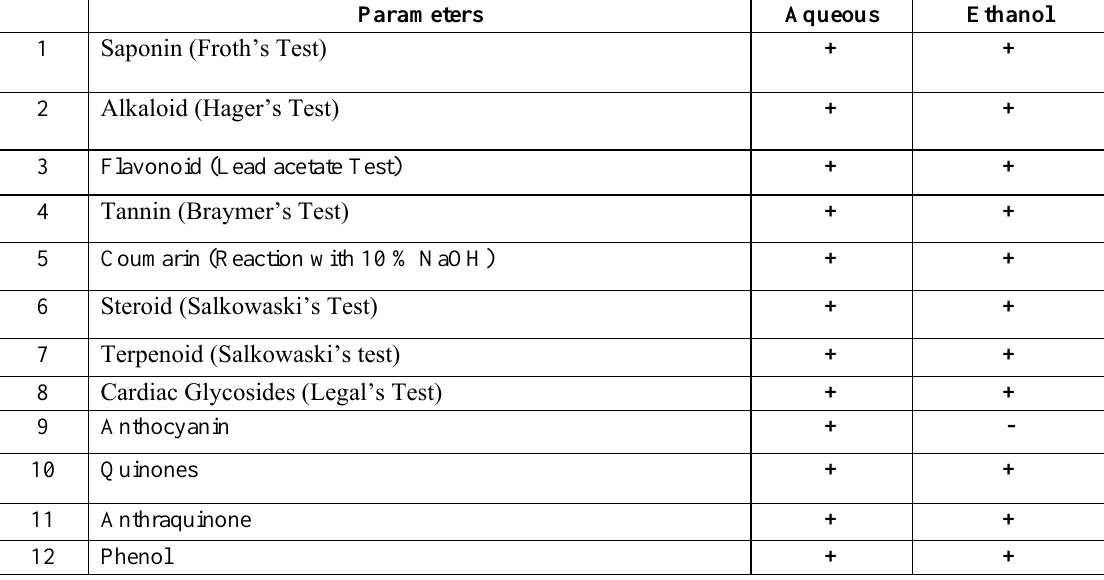
Table 1. Qualitative comparative results of phytochemical screening . The phytochemical compounds in Citrus peel ethanol and aqueous